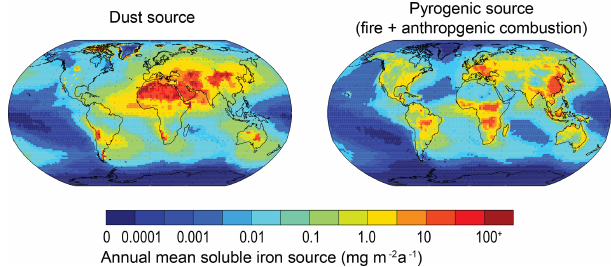
Figure 12. Annual mean dust and pyrogenic (sum of fires and an- thropogenic combustion) soluble iron source (i.e. sum of emissions and atmospheric processing).